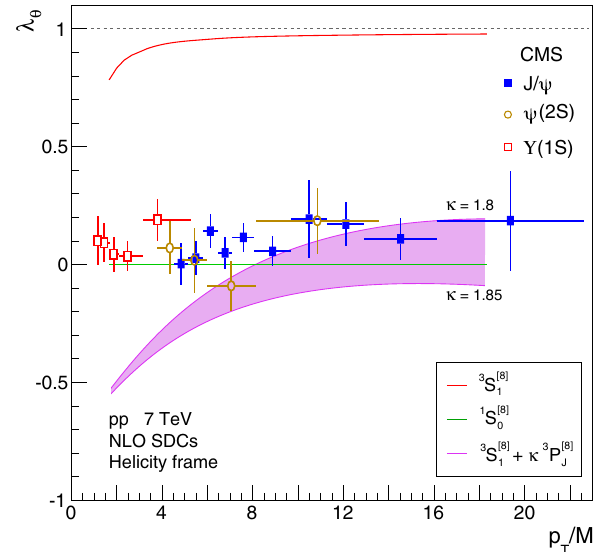
Fig. 3 Mid-rapidity quarkonium cross sections measured in pp col- √ s = 7TeV by ATLAS (red markers) [3–5] and CMS lisions at (blue markers) [6,7], with normalizations arbitrarily adjusted to the J /ψ points to illustrate the universality of the p T / M dependence. The data are compared to the shapes of the 1 S [ 8 ] + κ 3 P [ 8 ] 3 S [ 8 ] combination with κ = 1 . 8–1.85 (magenta band) J 1